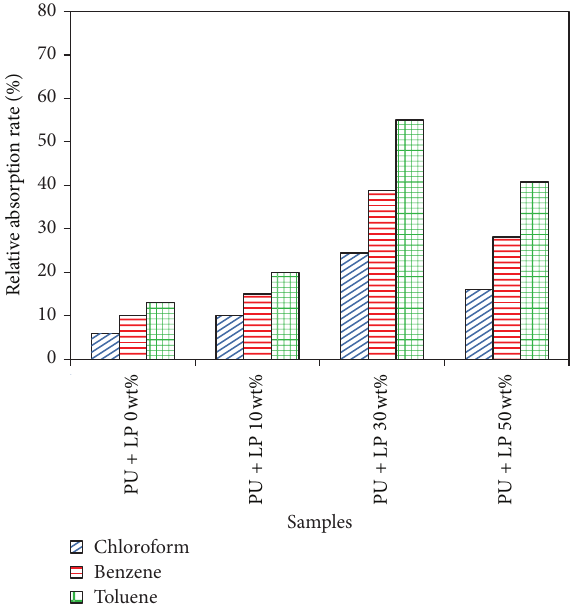
Figure 7: VOC absorption capacity of different nanofibrous mats.